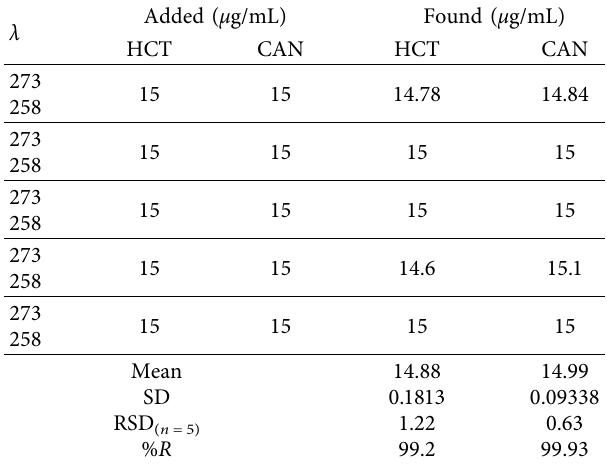
Table 12: Precision of the correction absorbance method in the determination of HCT and